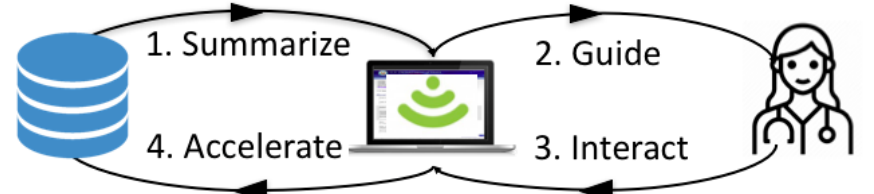
Figure 1. Domain expertise